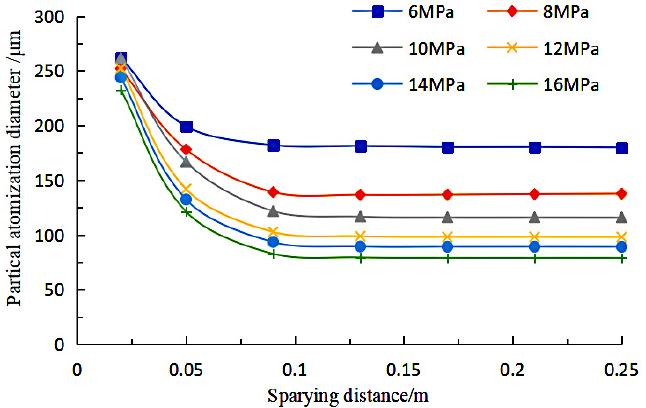
Figure 16. Relationship between particle atomisation diameter and spraying distance and pressure. different pressures, as shown in Figure 17.